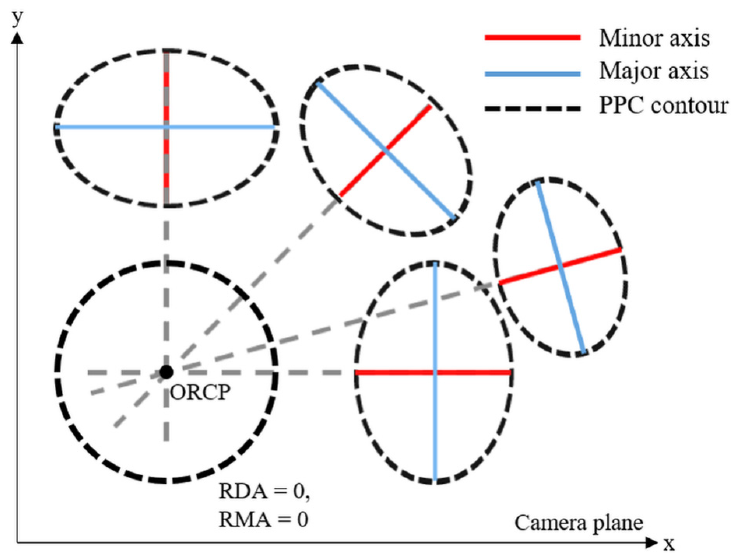
Figure 2. Conceptual diagram of ORCP positioned on the extension line of the minor axis of the PPC.